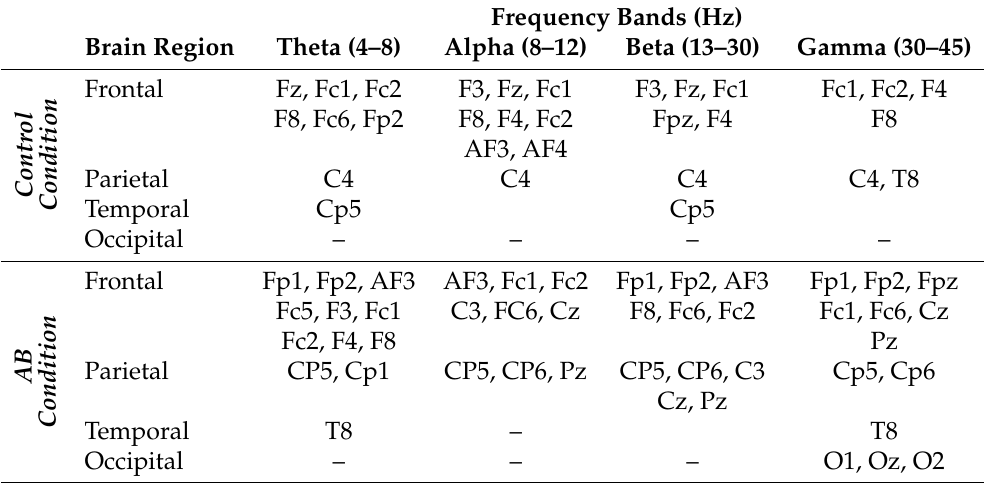
Table 4. Significant electrodes in different frequency bands ( p -value ≤